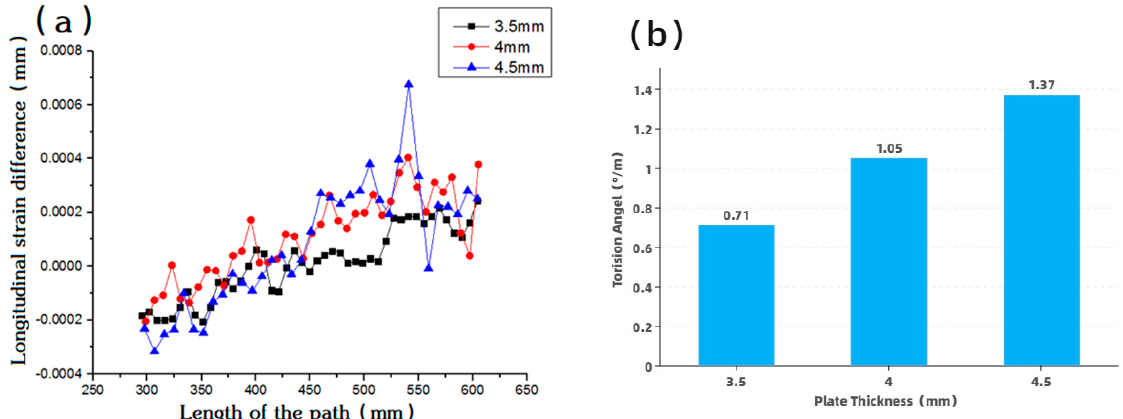
Figure 10. Simulation results of different plate thicknesses. ( a ) Influence of different plate thickness on torsion; ( b ) Torsion increase about 0.3°/m with an average 0.5 mm increase in plate thickness.